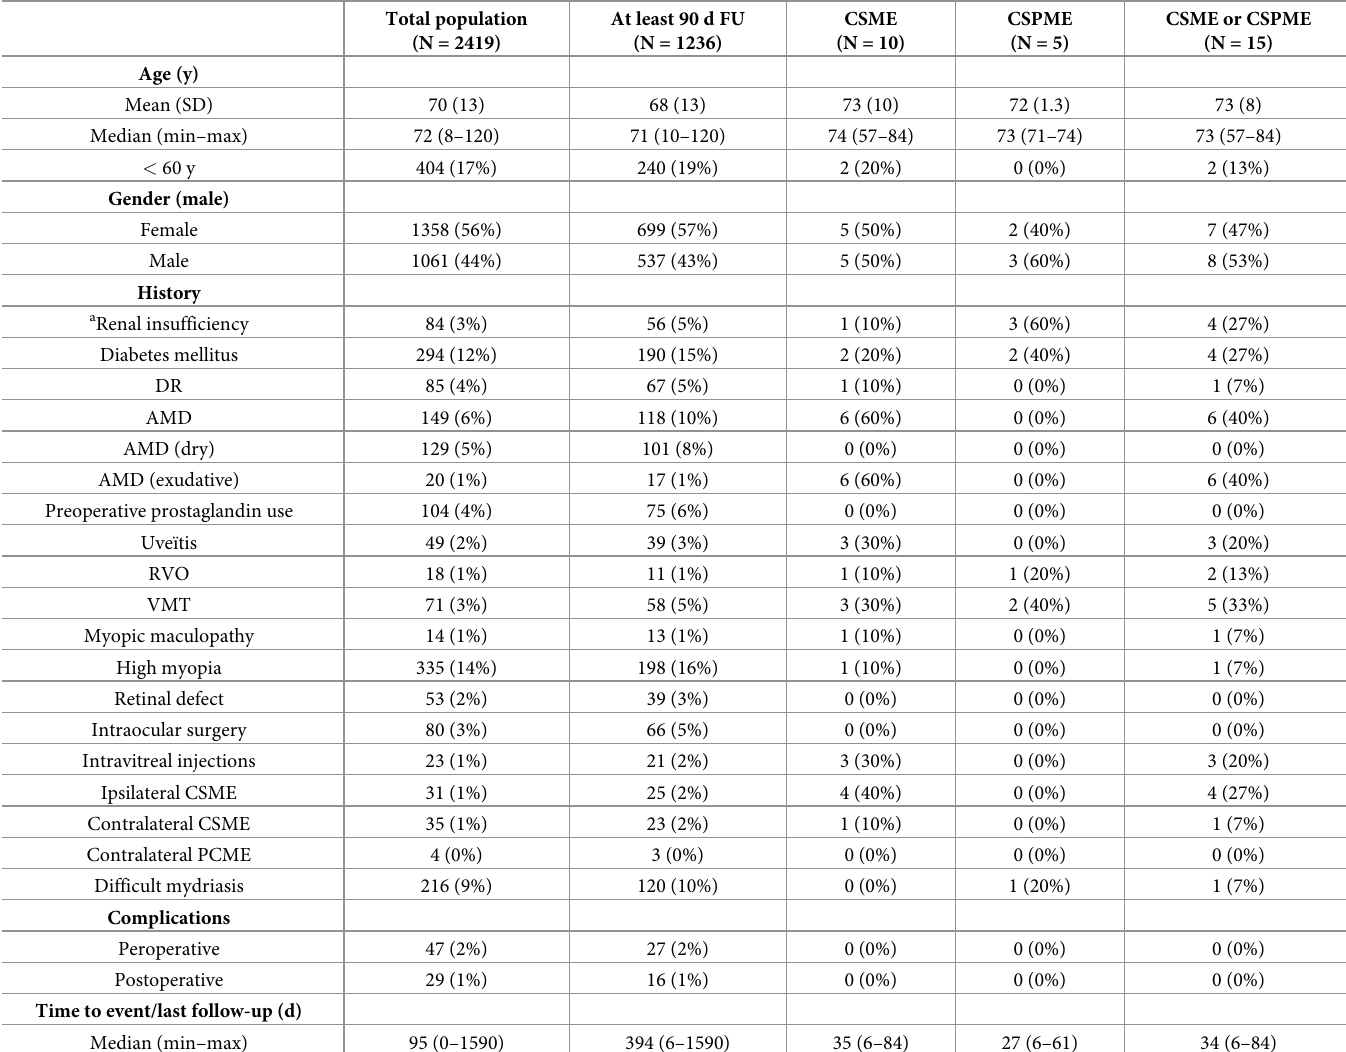
Table 1. Patient